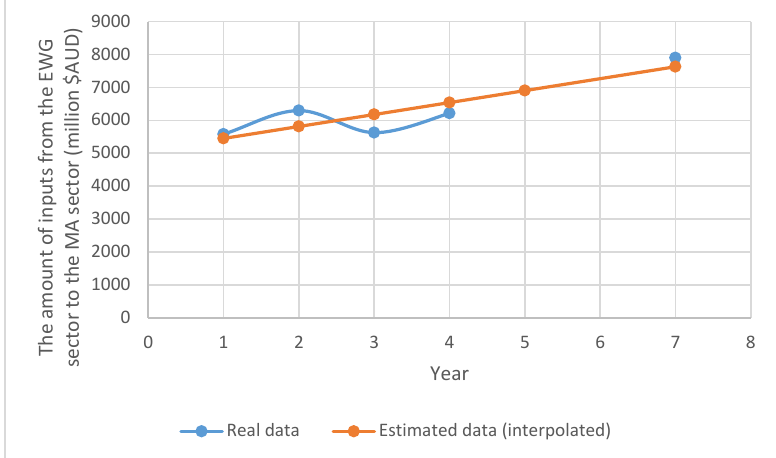
Figure 4. Inputs from the AG sector to the CO sector in Equation (4). Agriculture, forestry, and fishing = AG; Construction = CO. Table 3. Regression models with their main characteristics for the AOI sector to intermediate sectors using interpolation, coefficients ( n = 5). Dependent Variable